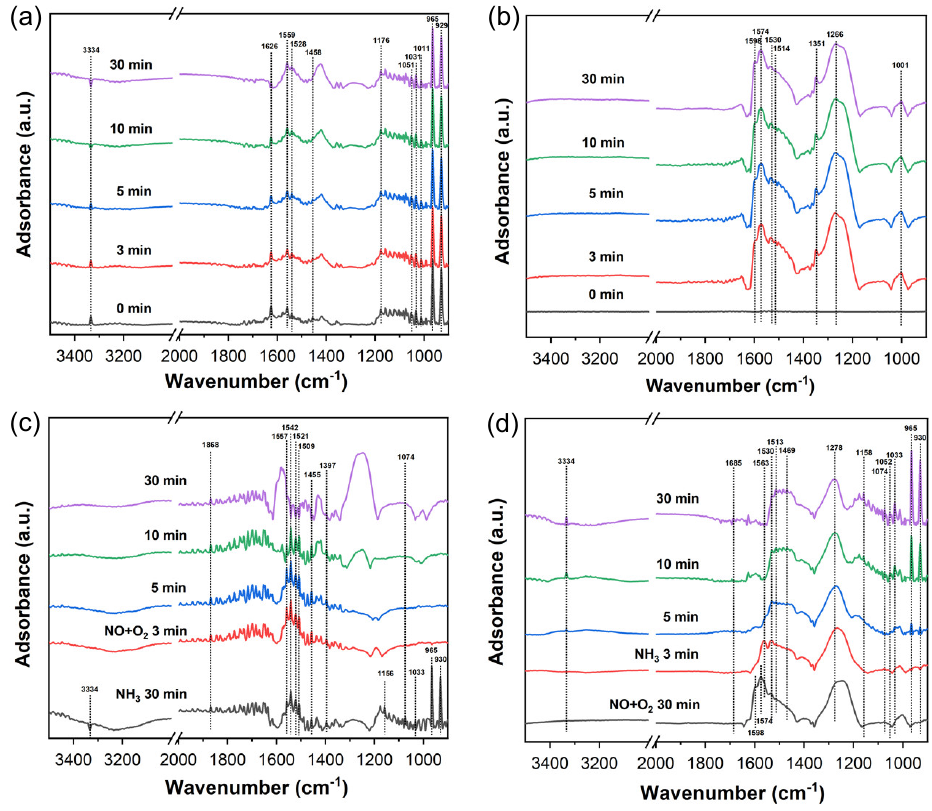
Figure 10. In situ DRIFTs of Ce/Mn-3 (300) at 200 °C over different time: ( a ) NH 3 adsorption, ( b ) NO + O 2 adsorption, ( c ) reaction of pre-adsorbed NH 3 with NO + O 2 , and ( d ) reaction of pre-adsorbed NO with NH 3 .